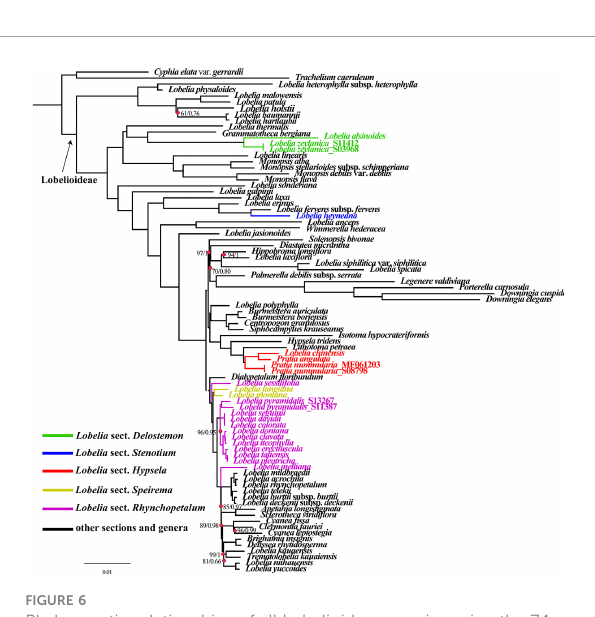
FIGURE 6 Phylogenetic relationships of all Lobelioideae species using the 74 protein-coding genes, based on the analyses of Maximum likelihood (ML) and Bayesian inference